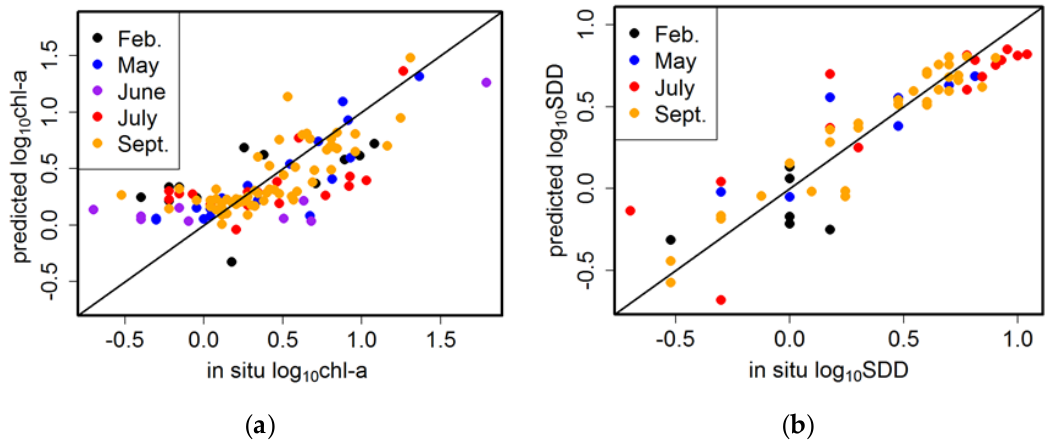
Figure 6. Comparison between MERIS estimates of chl-a ( a ) and SDD ( b ) using LME models and in situ measurements for Lake Erie. The solid diagonal line is the 1:1 line.